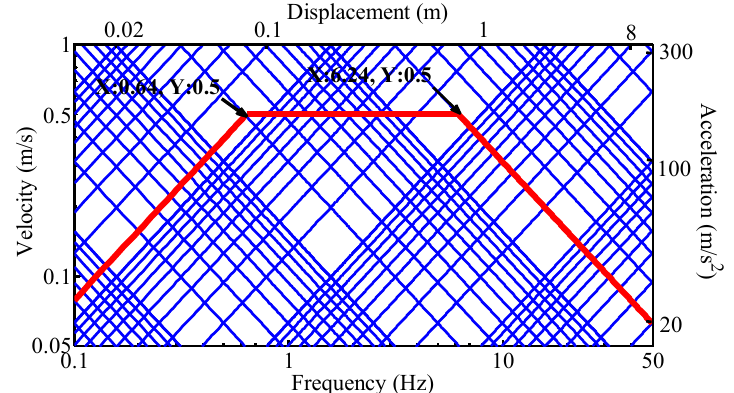
Figure 4. The maximum capability curve.